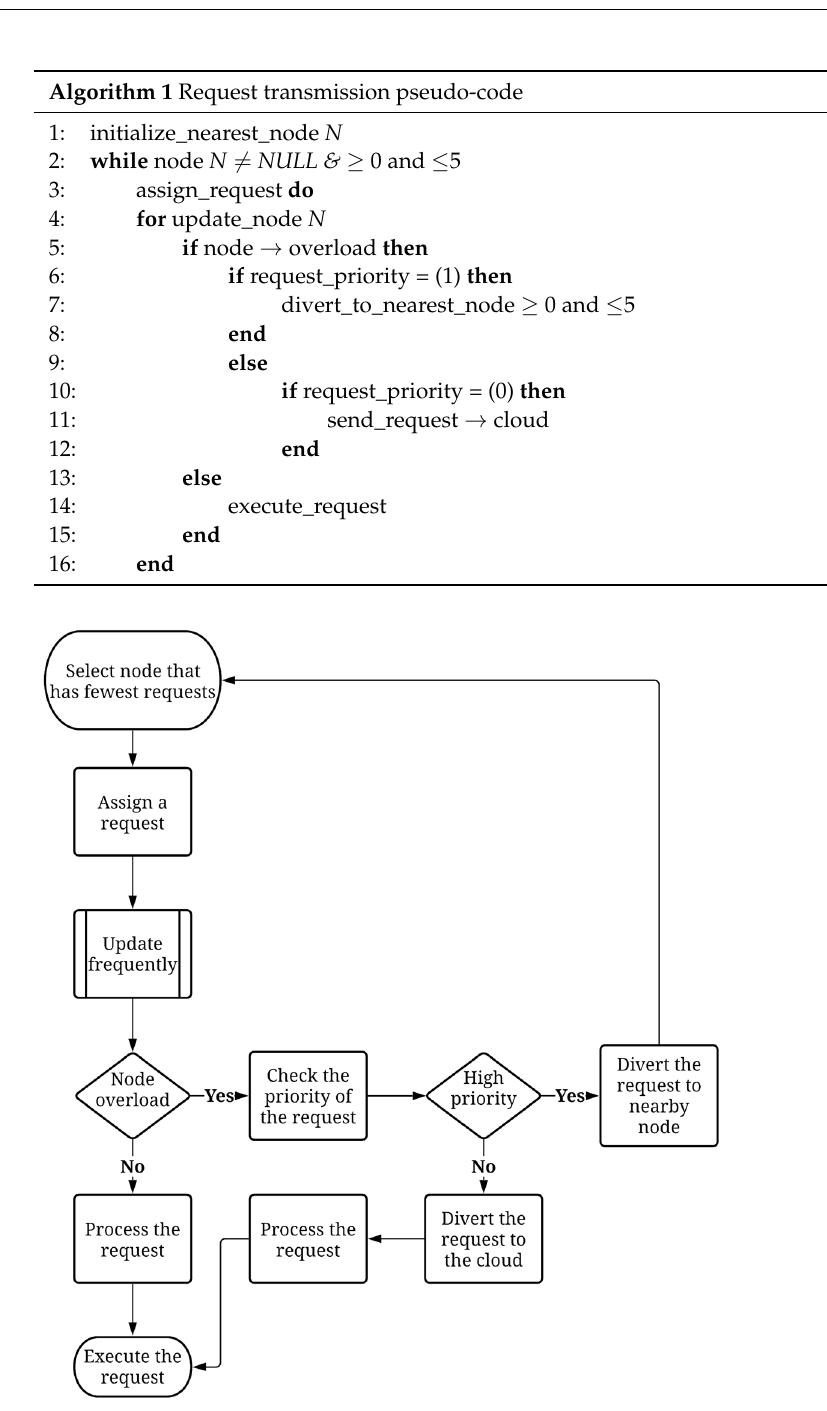
Figure 4. General flow of the request transmission process within the network.